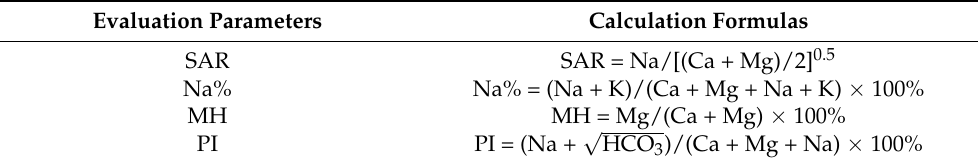
Table 1. Evaluation index and calculation formula of irrigation water suitability.